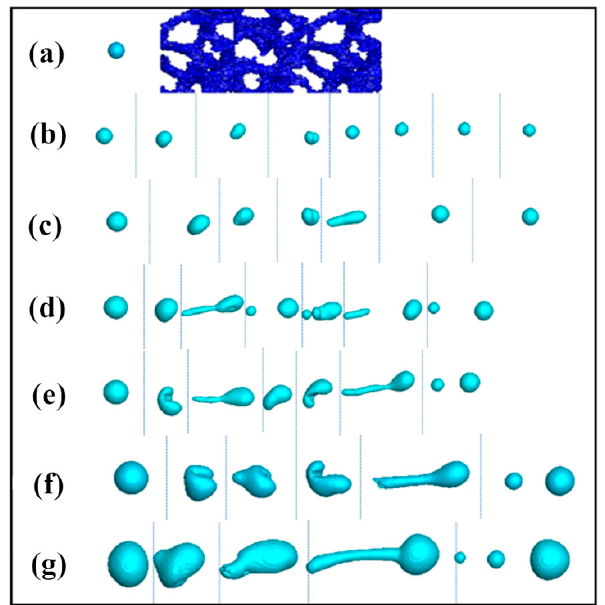
Figure 7. Hydrodynamics of one droplet passing a metal foam with di ff erent D d values ( L d = 7.32, Ca = 0.061): ( a ) schematic diagram, ( b ) D d = 0.89, ( c ) D d = 1.07, ( d ) D d = 1.25, ( e ) D d = 1.33, ( f ) D d = 1.82, and ( g ) D d = 2.24.